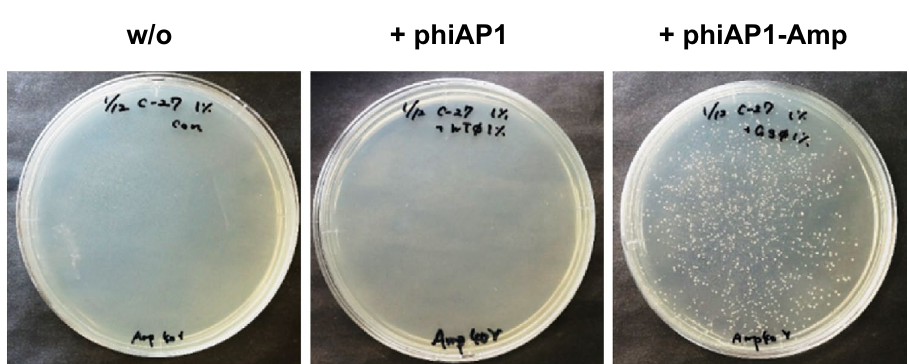
Figure 6. Infective ability of phiAP1 to the A. pasteurianus C-27 strain. The phiAP1 and phiAP1-Amp- containing fractions were prepared from A. pasteurianus NBRC 109446 wild-type and GMS3 strains cultured with YPG-1% glucose containing MMC. As a recipient cell, the C-27 strain grown in YPG-1% glucose was used. The phage-infected C-27 strains were selected on YPG-1% glucose containing ampicillin at 30 °C for 3